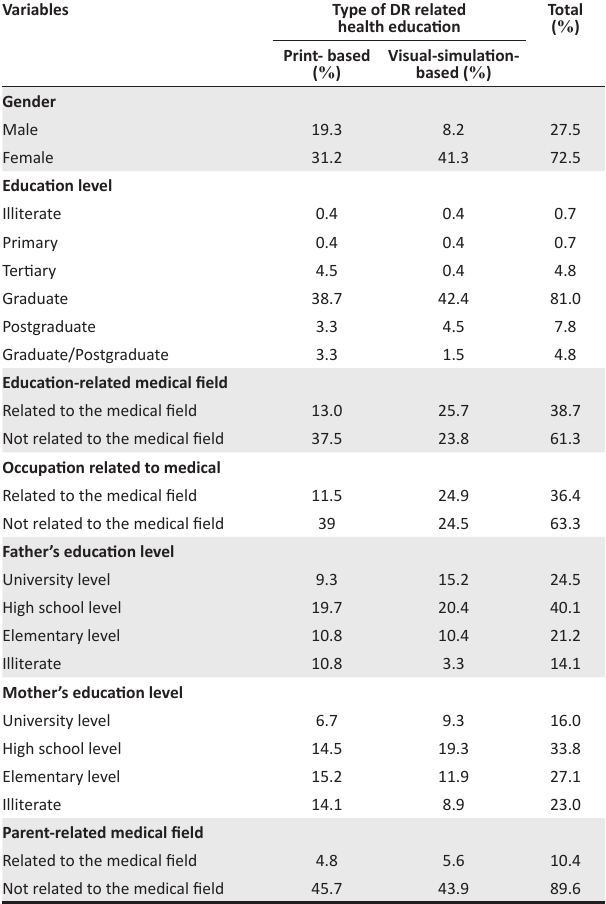
TABLE 1: The demographic profile of the study